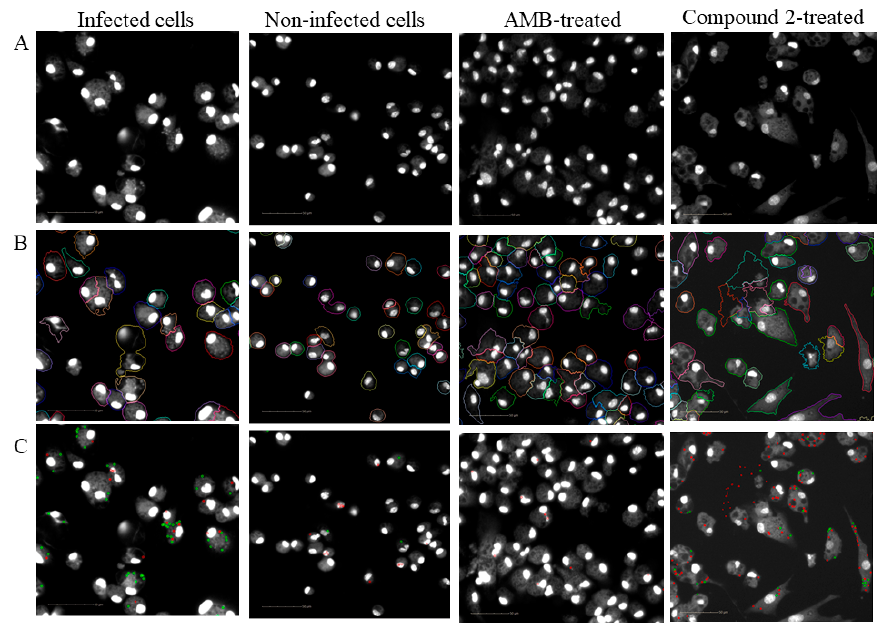
Figure 4. Image analysis process. Representative images of macrophages infected with L. amazonensis, non-infected control (mock), AMB-treated infected cell at 2 µ M and compound 2-treated infected cell at 10 µ M: ( A ) raw image acquired using the Hoechst channel; ( B ) cytoplasm segmentation based on nuclei selection using the “find cytoplasm” building block. Different colours are used to visually distinguish the cells; ( C ) discrimination between real parasites in the cytoplasm region (green) and non-parasite spot in the cytoplasm (red). Scale bar = 50 µ m.